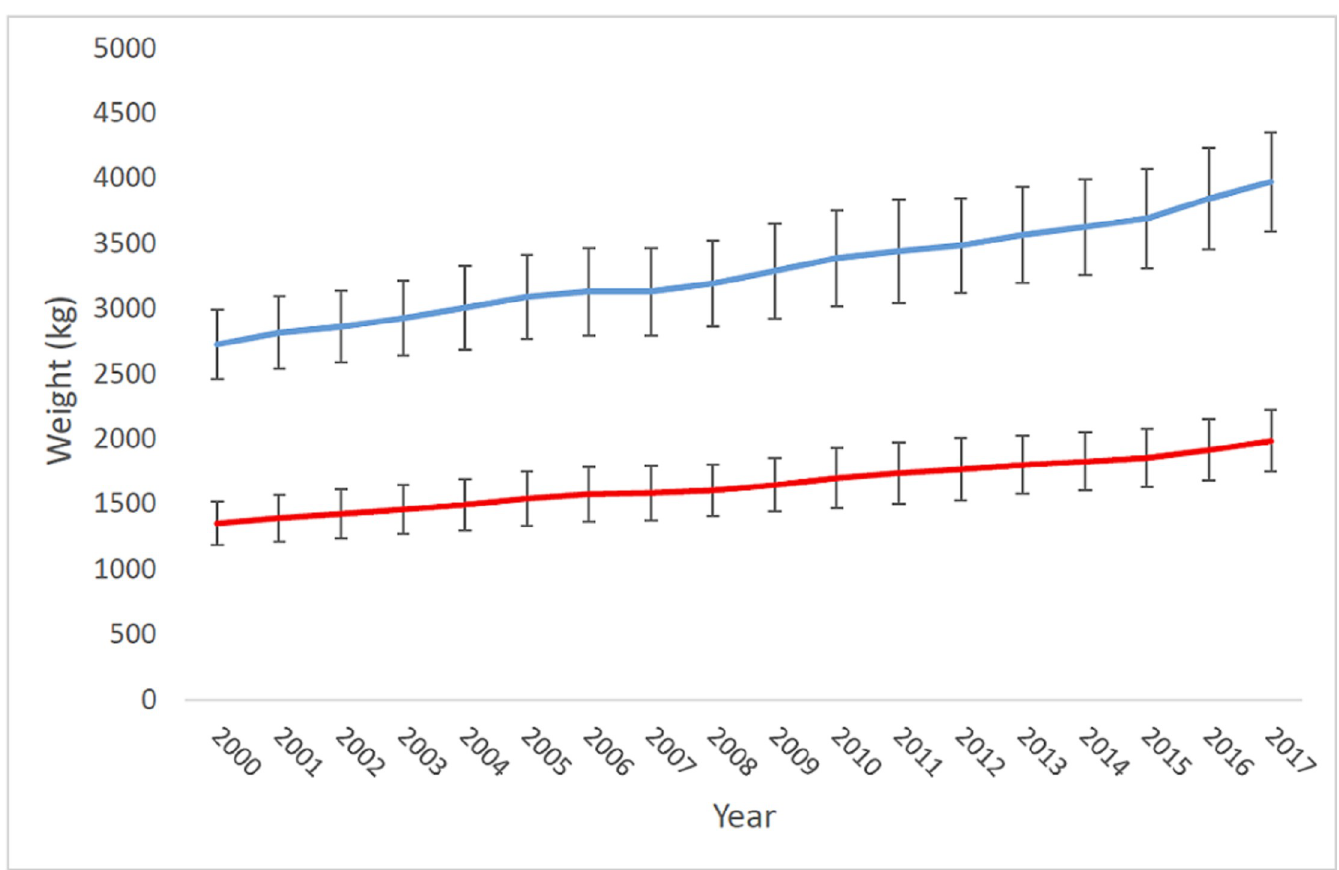
Fig 1. Increase in weight of breeding farm mink in Denmark from 2000 to 2017. (pers. comm. J. Clausen, Kopenhagen